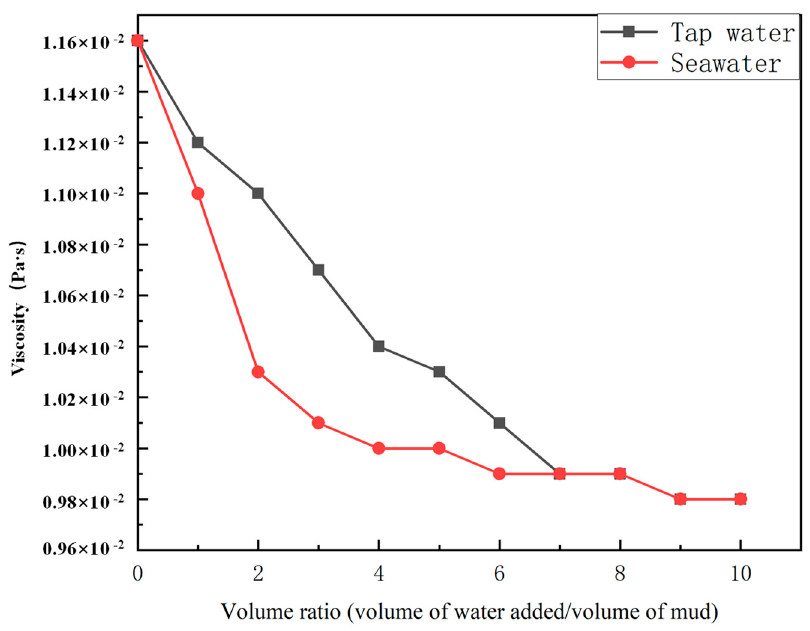
Figure 10. E ff ect of seawater on mud Figure 10. Effect of seawater on mud viscosity.